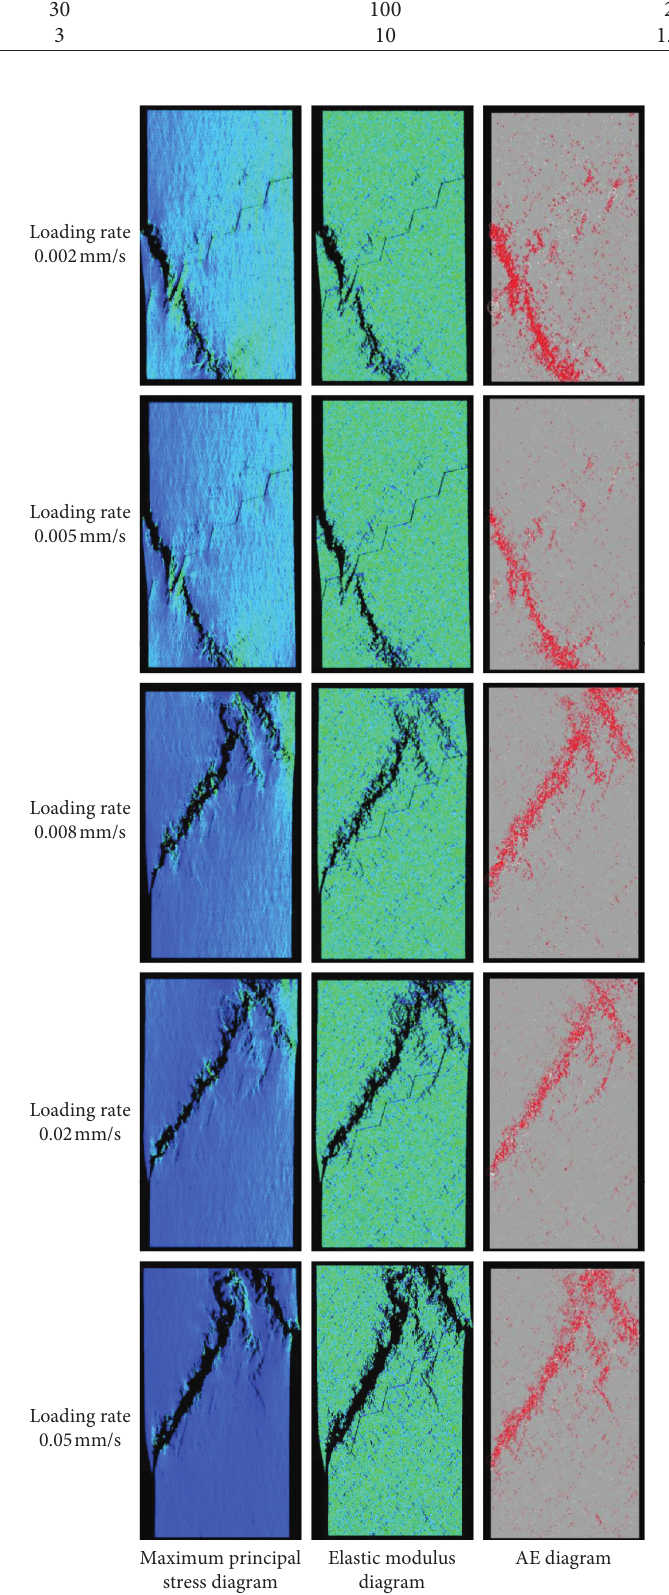
Figure 4: Failure mode of the numerical specimen C under different loading rates.